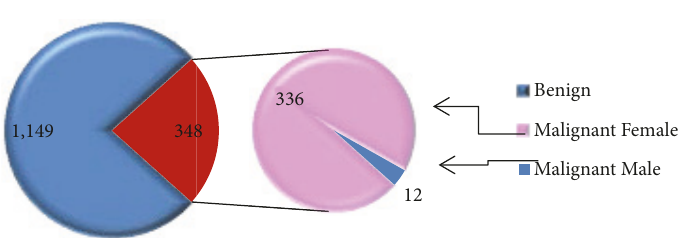
Figure 2: Total breast cases based on behavior from 2011 to 2017.